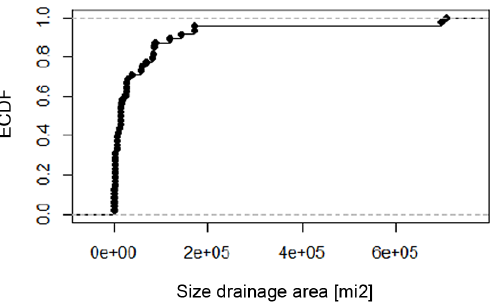
Figure 3. Empirical cumulative density function (ecdf) of sizes of drainage area for the river gauges that are being forecasted daily by the